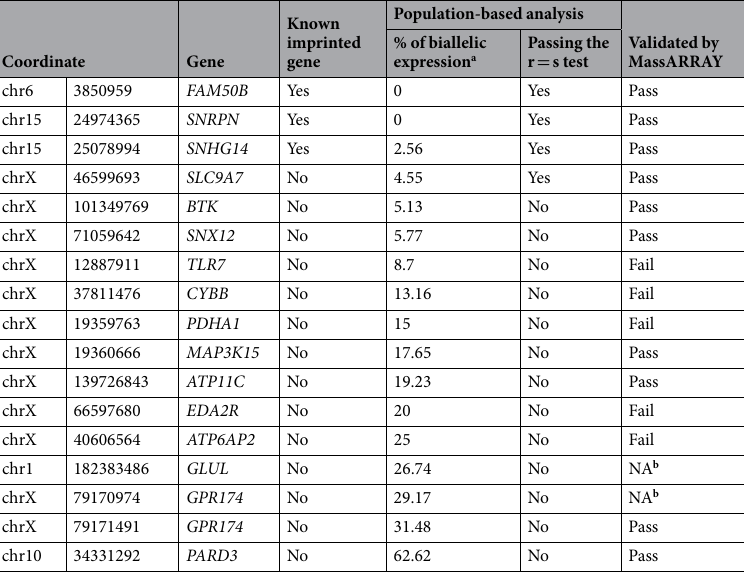
Table 3. Validation of the Category 1-1 ASE sites using the population-based analysis (i.e., the r = s test) and the MassARRAY platform. a The percentage of the Geuvadis individuals with biallelic expression at the variant sites. b The validation results were not available because we failed to design appropriate primer sequences for the MassARRAY